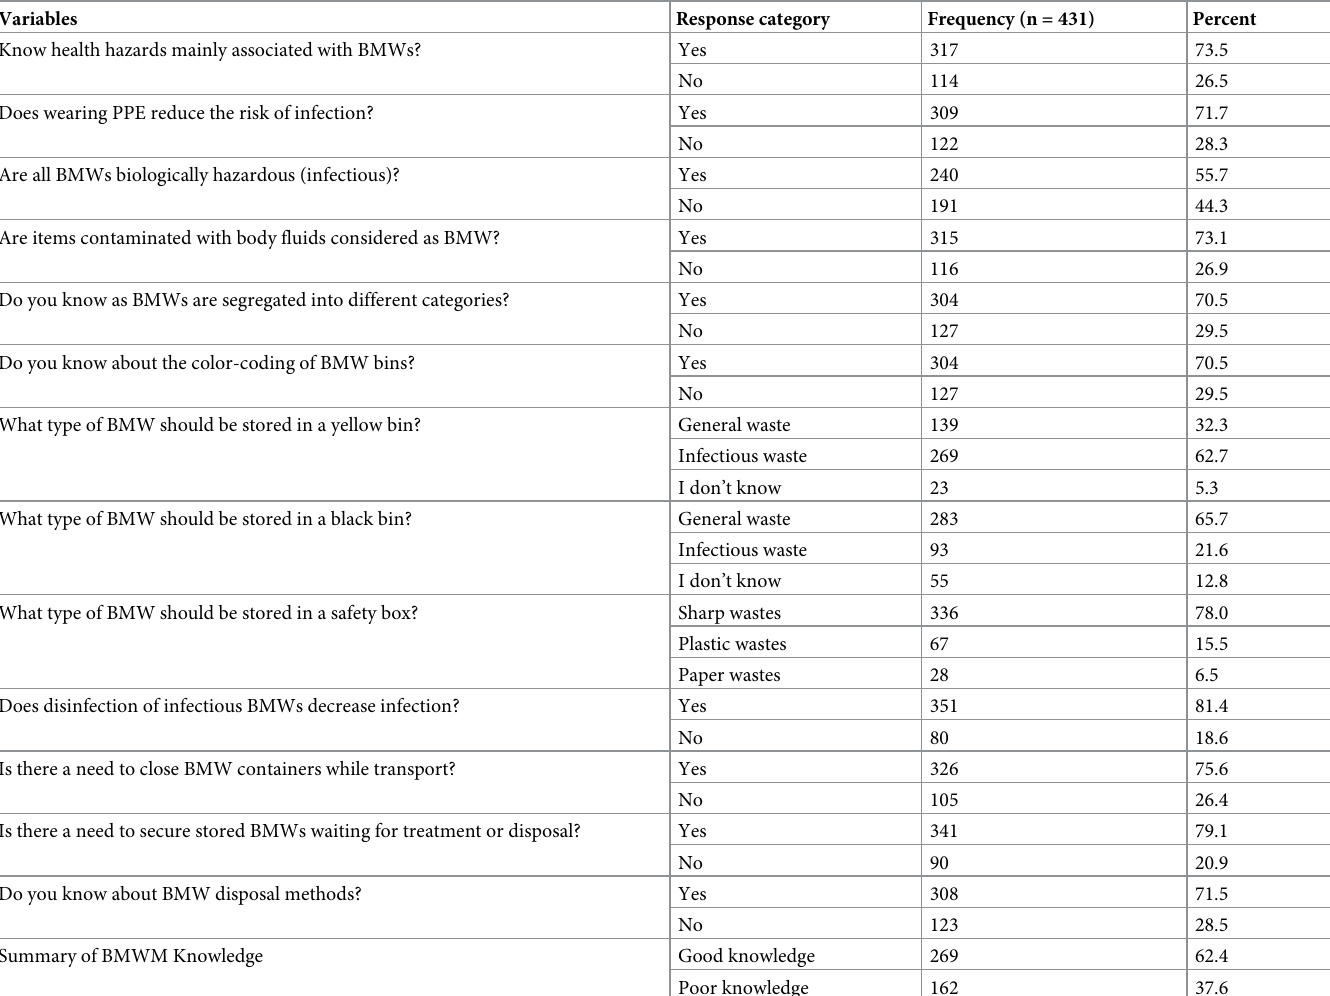
Table 3. Frequency of health care workers among each knowledge term question at metropolitan cities private hospitals of Amhara region, Ethiopia,